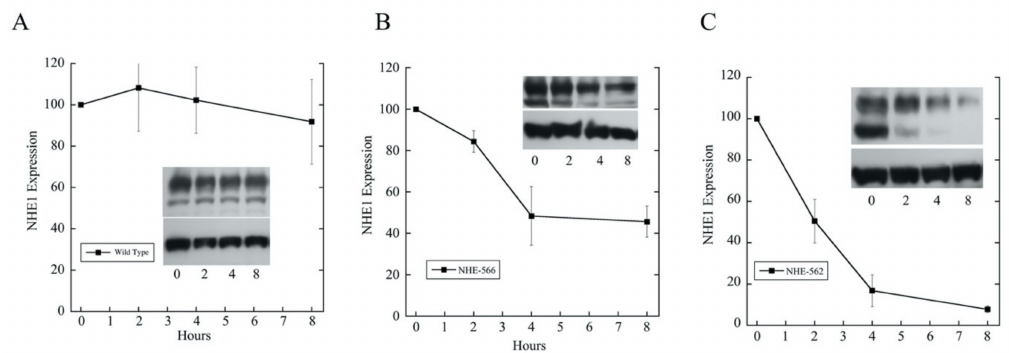
Figure 6. Protein levels of wild type and mutant NHE1 proteins were measured at time 0, (starting time) and up to 8 h after cycloheximide (50 µ M) treatment. Equal amounts of total proteins were loaded in each lane, and NHE1 levels were then determined by Western blotting against the HA tag on NHE1. Quantification was estimated by using the Image J 1.35 software. Insets are example Western blots that show NHE1 levels in the upper panel in comparison to tubulin levels (lower panels). Time points are at 0, 2, 4 and 8 h. Results are mean ± S.E. of at least 3